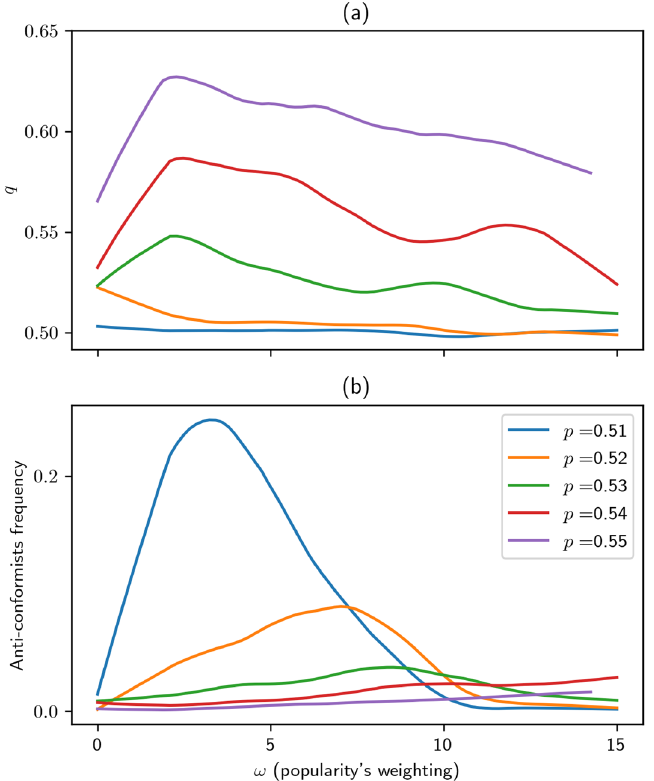
Figure 6. Effect of ω on F success rate q ( a ), and on anti-conformists prevalence ( b ), with c = .01 and various values of p . Lines are local regressions through data points (not shown for